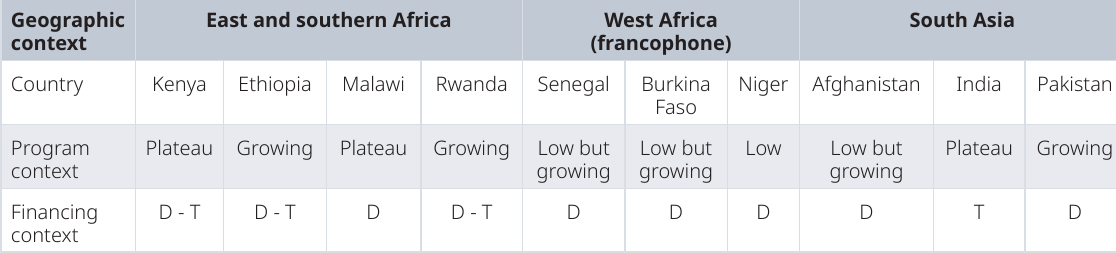
Table 1. Country geographic, programmatic and financing contexts. Geographic